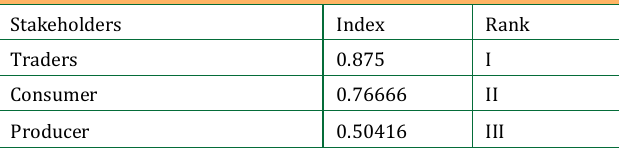
Figure 3: Value addition map of mandarin orange